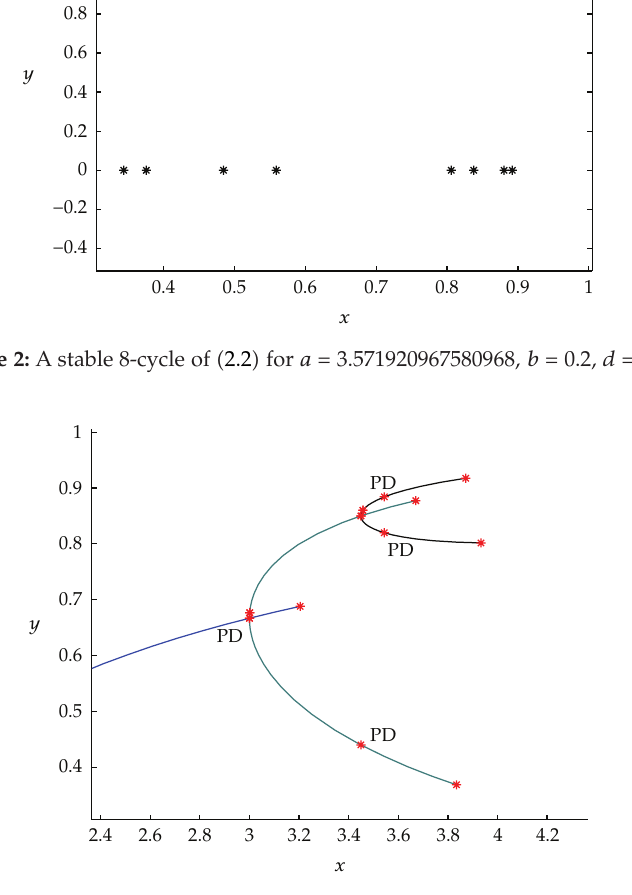
Figure 3: Curves of fixed points of the first, second and fourth